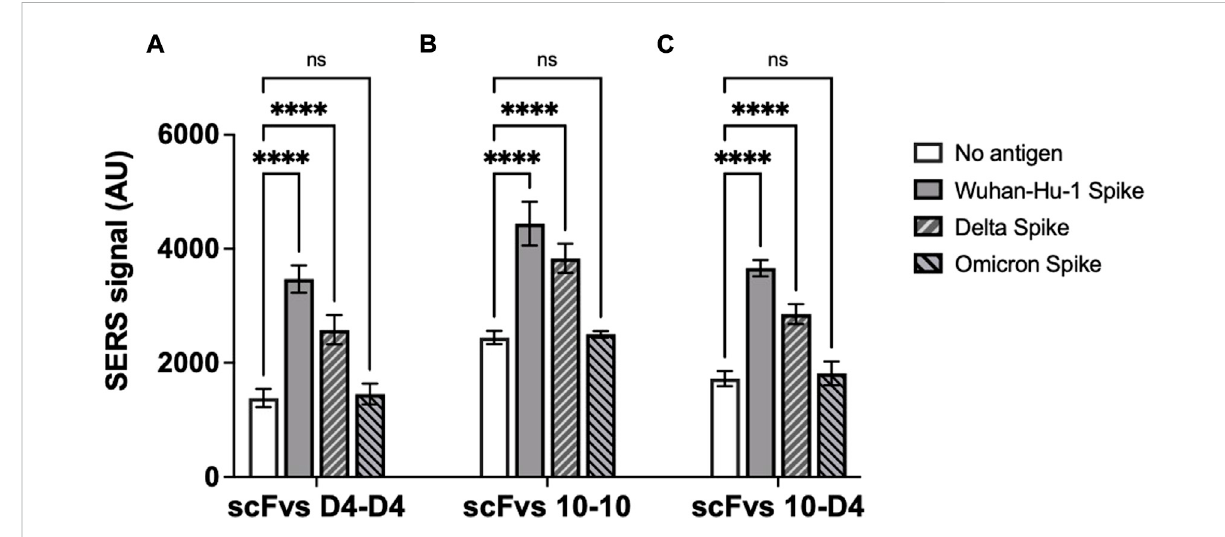
FIGURE 4 ScFv D4 and scFv 10 binding to spike proteins from SARS-CoV-2 Wuhan-Hu-1 virus and Delta and Omicron variants. Panels represent assays carried out with (A) scFv D4 on both magnetic nanoparticles and SERS nanotags, (B) scFv 10 on both particles, and (C) scFv 10 on magnetic nanoparticles with scFv D4 on SERS nanotags. Values represent the average of three replicate wells, and error bars indicate the standard deviation. For statistical analysis, two-way ANOVA followed by Dunnett ’ s multiple comparisons test was performed: ****: p < 0.0001; ns: not signi fi